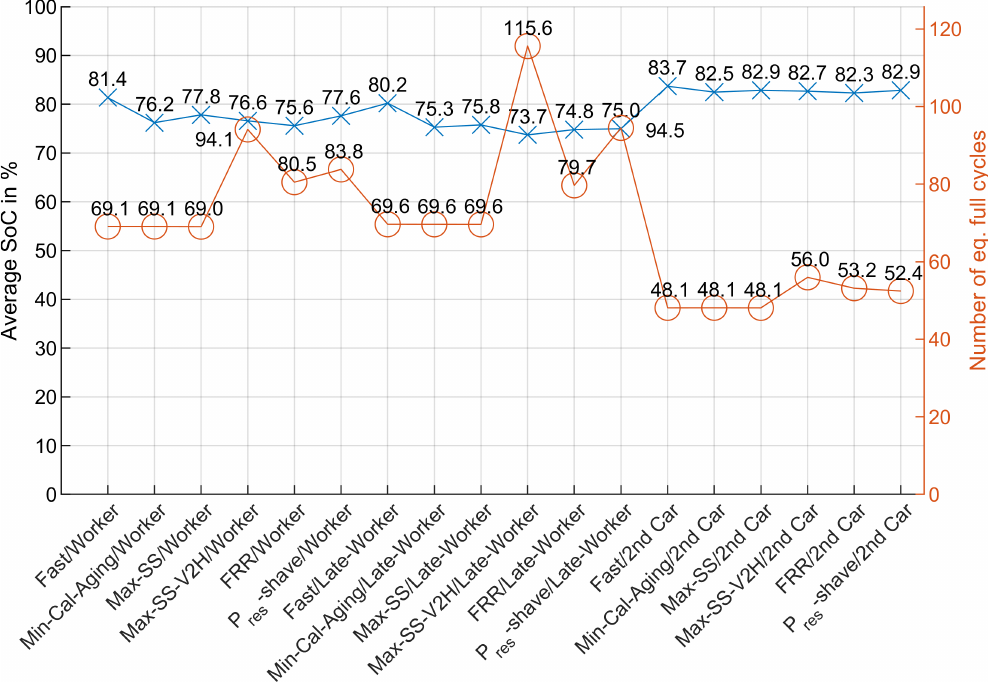
Figure A10. Average SoC and number of eq. full cycles for scenario workplace charging W and without SoC V 2 XLimit